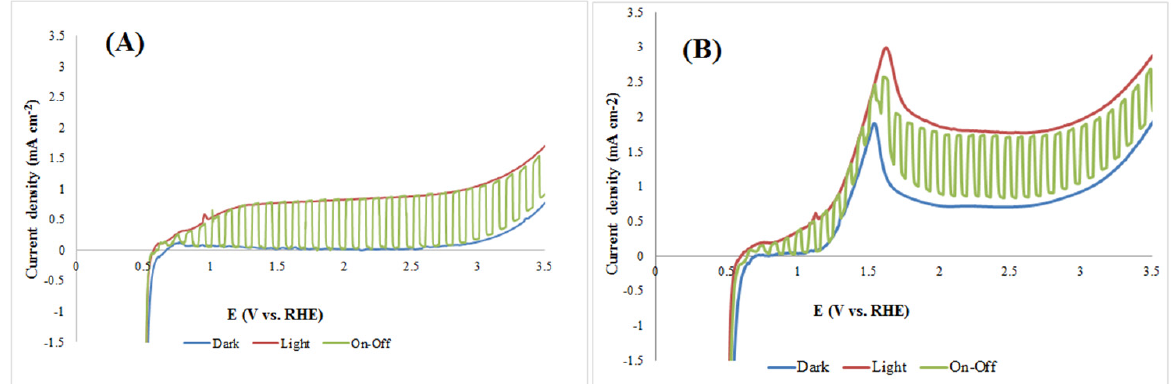
Figure 4. LSV of Pt-CT-1 ( A ) and Pd-CT-1( B ) electrodes under illumination of Xe lamp, in the dark and chopped light in solution of KOH (1 M) with 5 vol% EG.